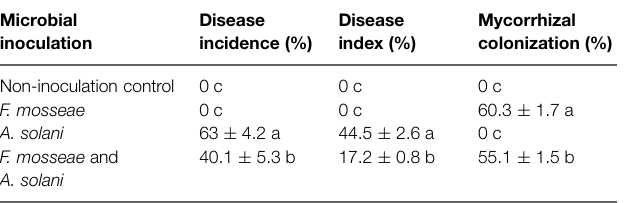
TABLE 2 | Mycorrhizal colonization rates, disease incidences, and indices of tomato plants inoculated with either Funneliformis mosseae , Alternaria solani, or both.